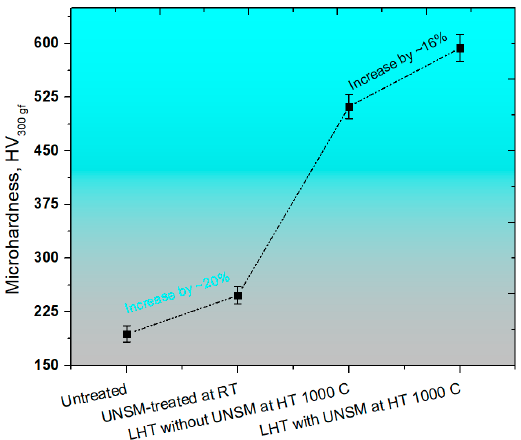
Figure 6. Comparison in surface hardness of the untreated, UNSM-treated at RT and LHT without and with UNSM treatment at 1000 °C specimens.